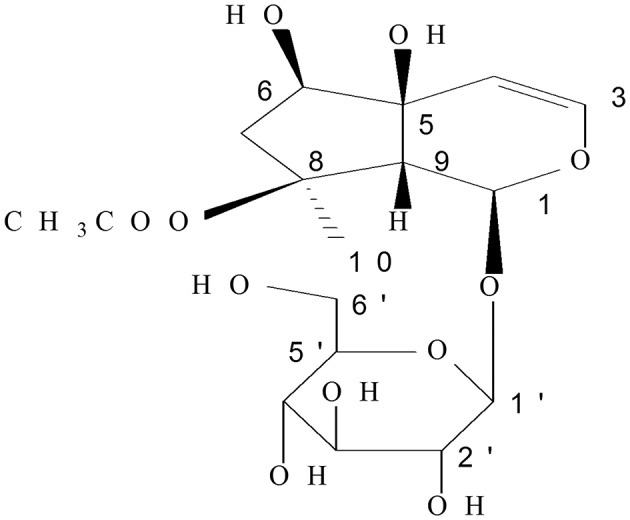
Chemical structure of acetylharpagide.